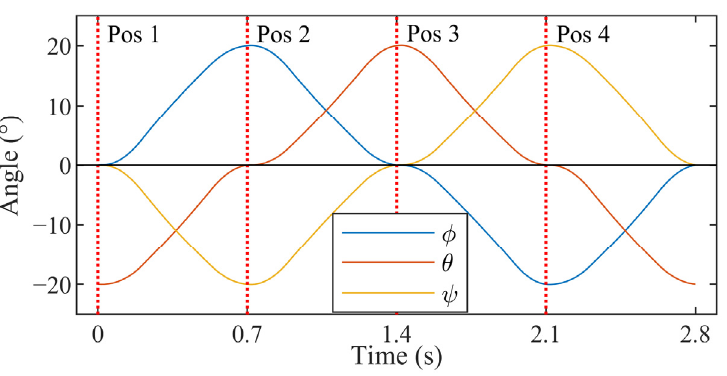
Figure 6. Plot showing the robot arm orientations throughout one example cycle. The red dotted lines represent the times at which the robot was at one of the orientations defined by the test plan.